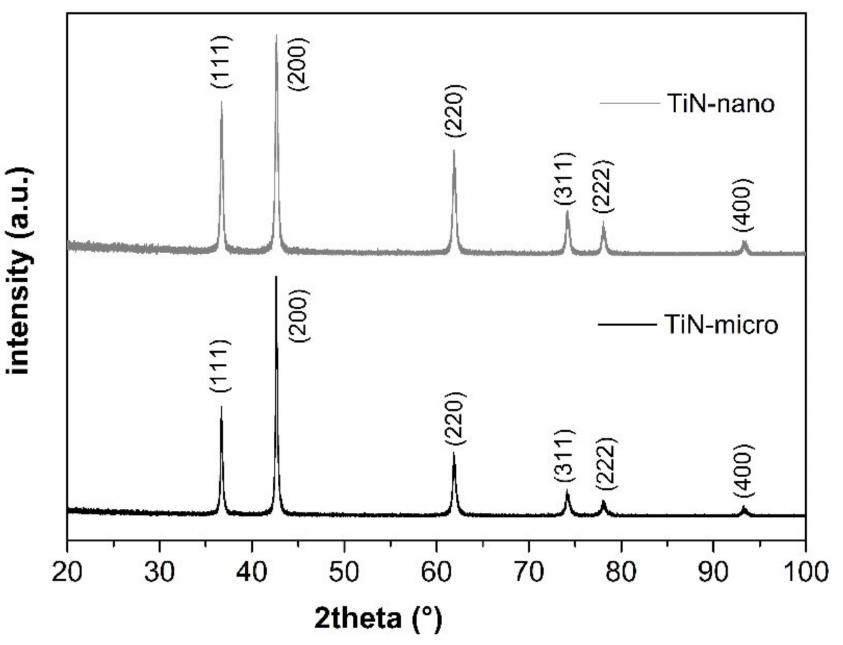
Figure 3. XRD patterns of as received micro-TiN e nano-TiN powders. XRD profiles of both TiN samples show reflections which are assigned all to the (111), (200), (220), (311), (222), and (400) crystal planes corresponding to a fm-3m face centered cubic phase, (space group 225, JCPDS 38–1420) [56]. No other peaks related to other secondary phases are present in the spectra. In Figure 4, XPS photoemission spectra of TiN-micro and TiN-nano powders are displayed. The XPS core level spectra for Ti 2p and n 1s are shown in Figure 4a,b respectively. In the deconvoluted Ti 2p spectra, the different contributions of titanium in the system are shown, represented by different Voigt-type doublets due to the spin-orbit interaction (2p3/2–2p1/2 spin orbit splitting of about 6.4 eV). In particular, the doublet with the Ti 2p3/2 peak centered at about 456 eV is associated to the presence of TiN. The doublet with 2p3/2 component at about 459 eV is related to the presence of oxy-nitride structures, TiOxNy, in good agreement to data reported in